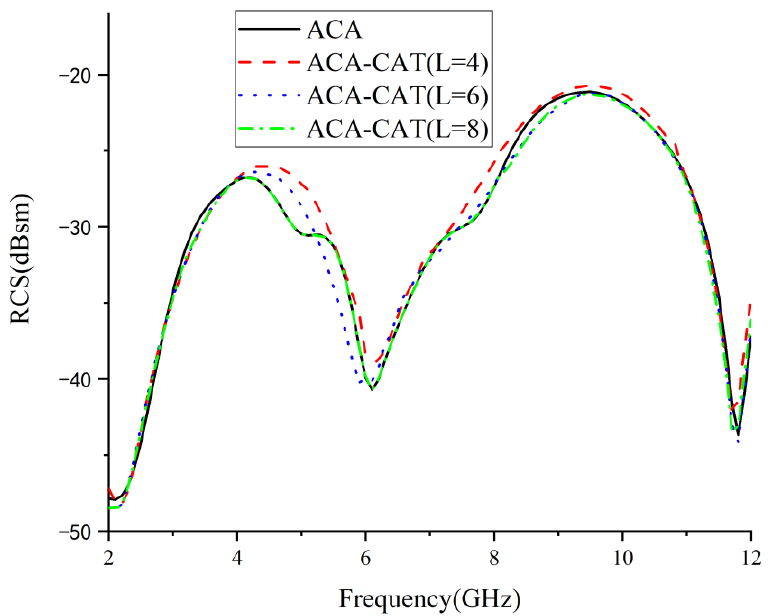
Figure 9. Broadband BCS of the four discrete objects is computed by ACA-CAT for three different orders.